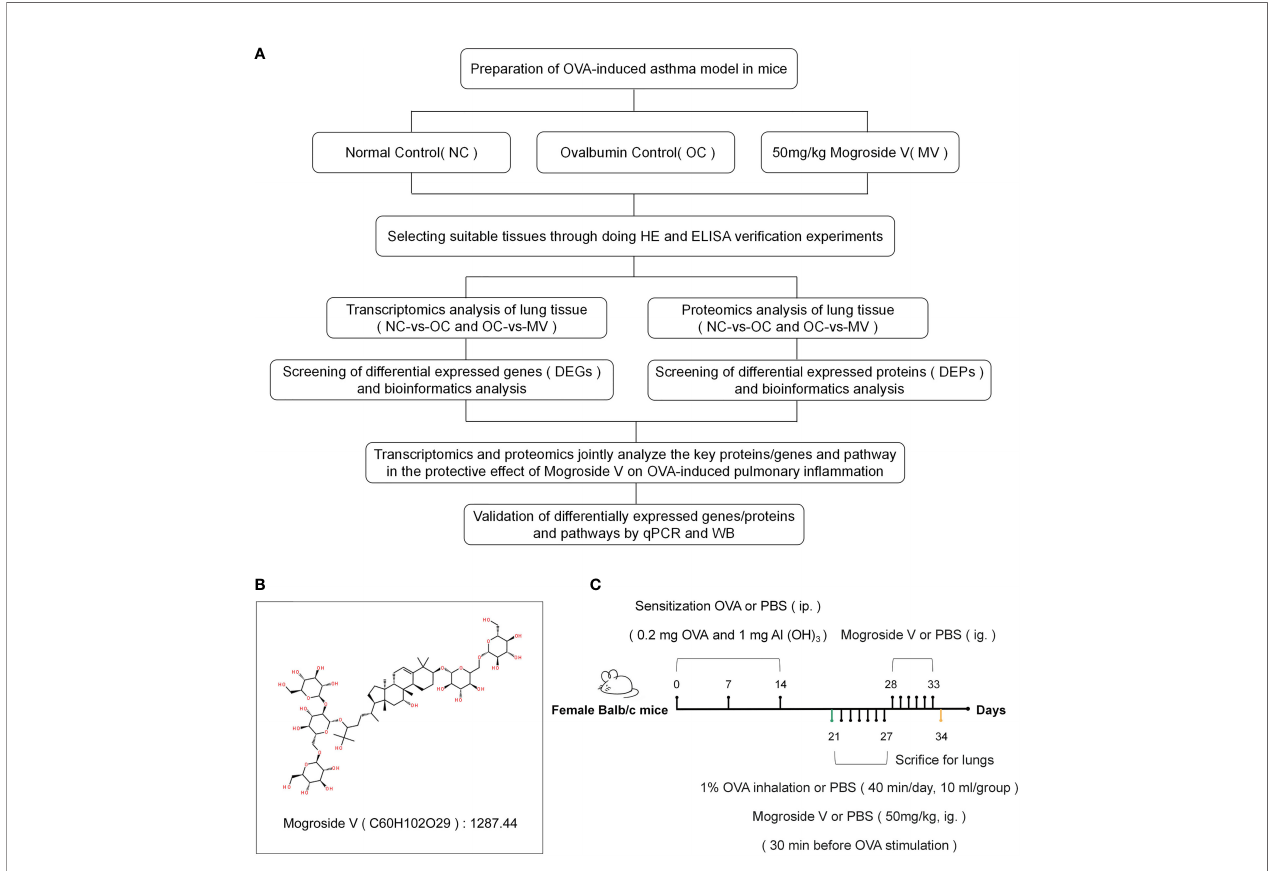
FIGURE 1 | (A) Overall approach of the study. (B) Molecular structural formula of mogroside V. (C) Establishment of a mouse model of asthma and drug